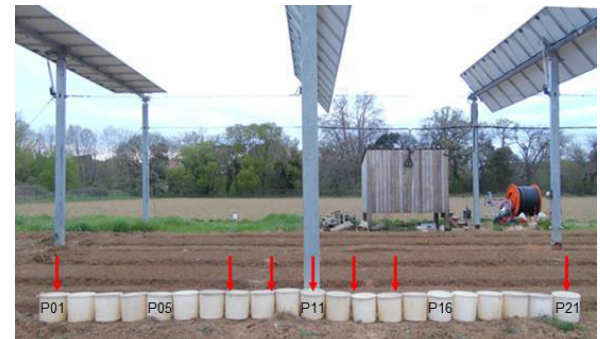
Figure 1. Effective rain and soil water content measurement under solar panels. Red arrows indicate the position of neutron probes, on a line parallel to that of the collectors, 1m before it. Some of the P01 to P21 collectors have been identified on the picture for clarity.